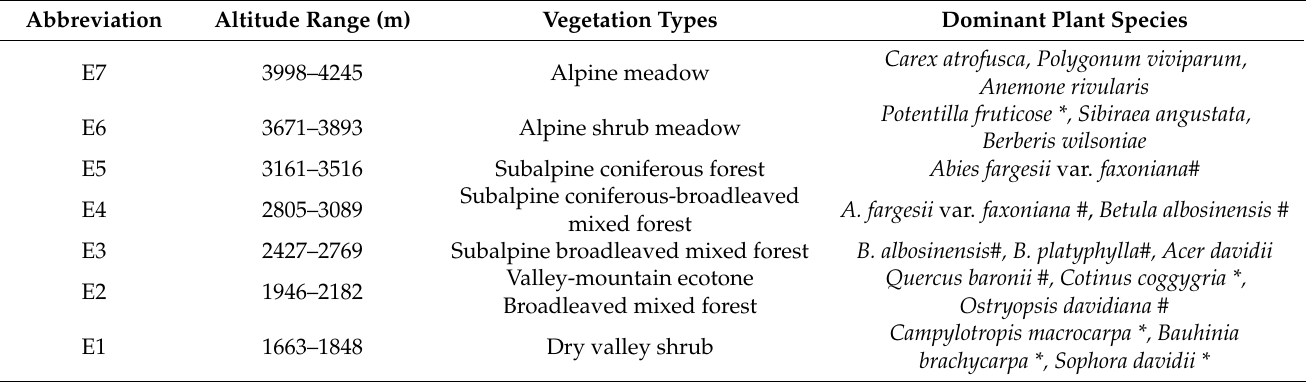
Table 1. Description of sampling sites along altitude gradients in the alpine–gorge region. The listed plant species marked with * and # represent arbuscular mycorrhizal (AM) and ectomycorrhizal (EcM),